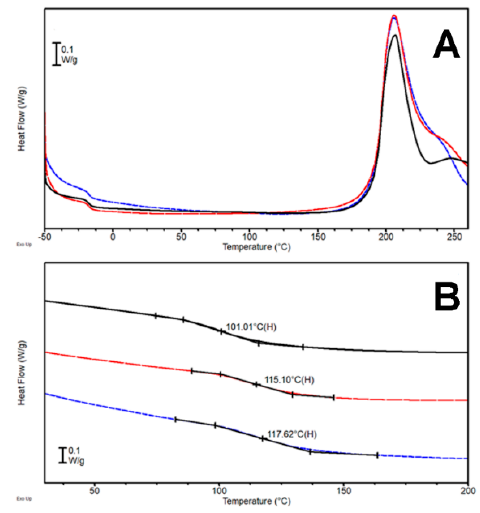
Figure 3. ( A ) DSC first heating scan (heating rate 5 °C/min) and ( B ) second heating scan (heating rate 20 °C/min) for the systems DTB-1 (—), DTB-2.5 (---), and DTB-5 (---).